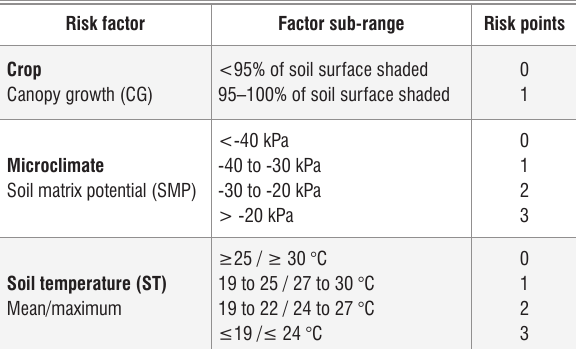
Crop and microclimate risk factors, factor sub-ranges and corresponding multiplier values of points used to calculate risk for the occurrence of apothecia and ascospores of